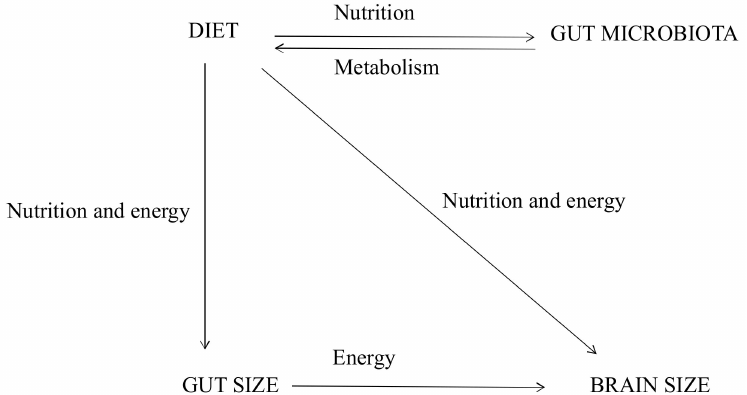
Figure 3. The Relationship Between Gut and Brain